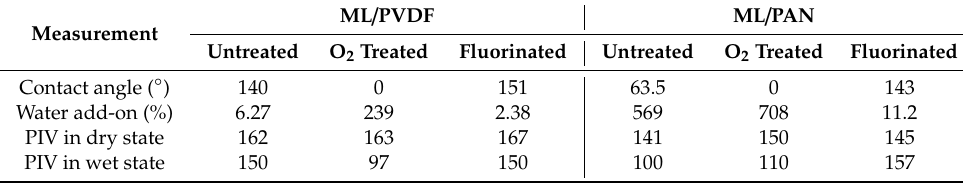
Table 2. Wettability, water add-on, and ML intensity of ML / polymer composite fabrics. ML / PVDF ML / PAN Measurement Untreated O 2 Treated Fluorinated Untreated O 2 Treated Fluorinated Contact angle ( ◦ ) 140 0 151 63.5 0 143 Water add-on (%) 6.27 239 2.38 569 708 11.2 PIV in dry state 162 163 167 141 150 145 PIV in wet state 150 97 150 100 110 157